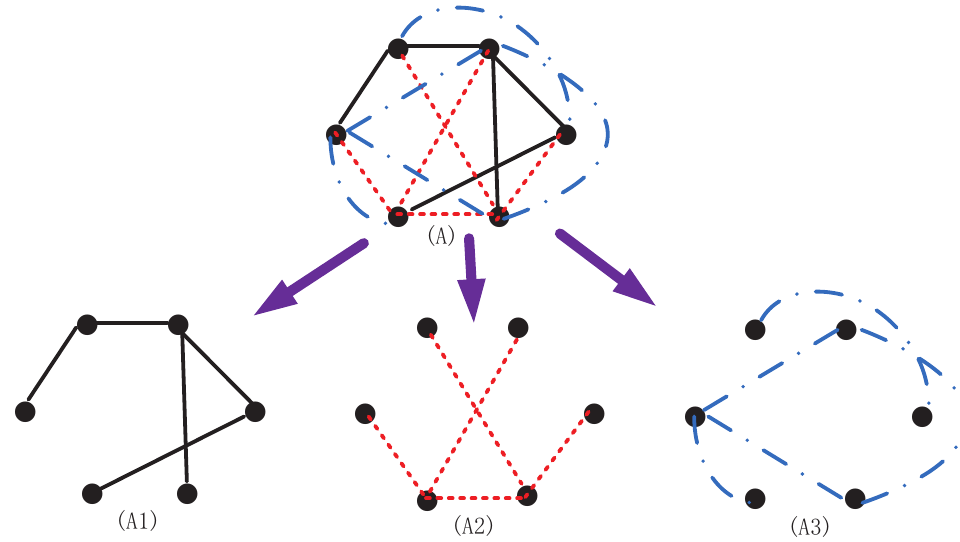
Figure 1. ( A ) Complete transportation network; ( A1 ) aviation network; ( A2 ) land network; and ( A3 ) waterway